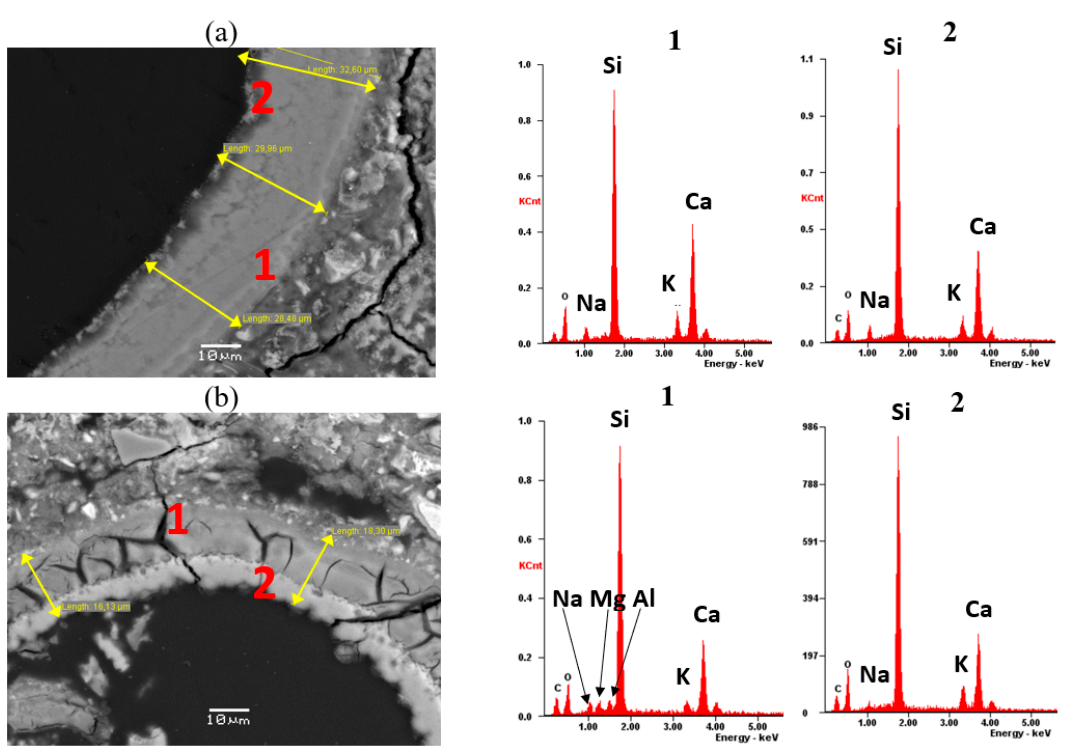
Figure 4. Microstructure and chemical composition of the ASR gel in air voids in specimens: ( a ) reference, 0% calcined clay and ( b ) 20% calcined clay, SEM-EDS, scale bar = 10 µm.